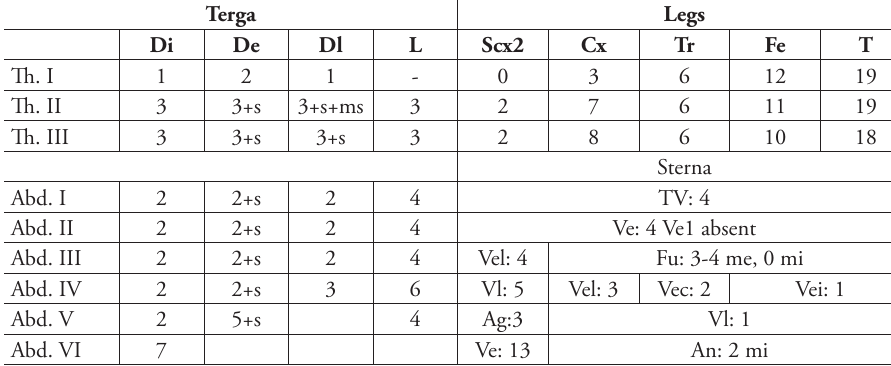
Table 1c. Chaetotaxy of Lobellina weinerae sp. n.: postcephalic chaetotaxy.